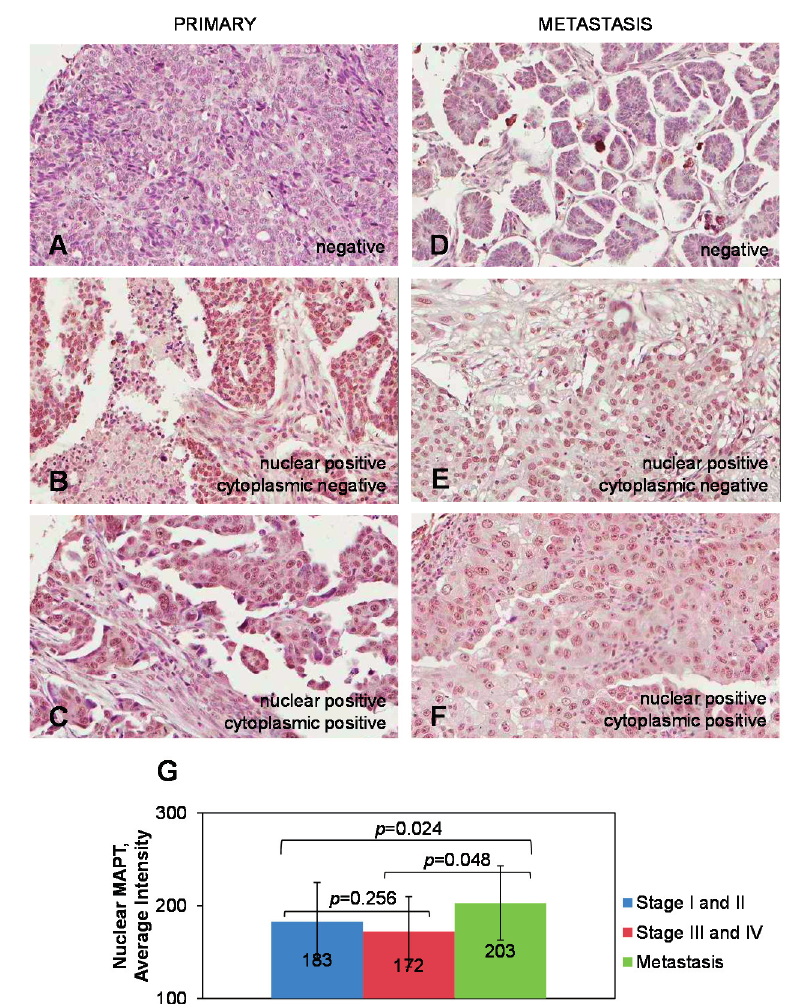
Figure 1. Expression of tau in specimens of primary and metastatic serous ovarian carcinoma. ( A – F ) Representative images of positive and negative tau expression in specimens of primary and metastatic serous ovarian carcinoma, as indicated. Brown color demonstrates tau staining. Blue color demonstrates staining with hematoxylin. Images were generated using an Aperio ScanScope digital slide scanner. Magnification: 10×; ( G ) Averaged tau expression in the specimens of primary and metastatic serous ovarian carcinoma. Nuclear intensity of tau ± standard deviation is shown. Data analysed with the Student’s t